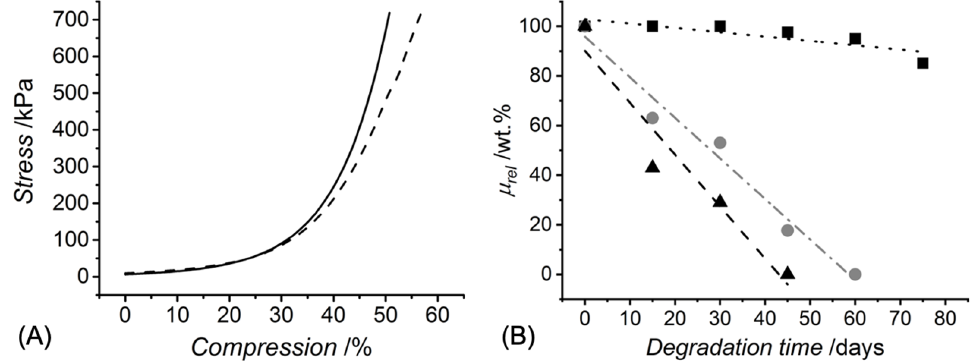
Figure 2. ( A ): stress-compression curves of hydrogels 4VBC-MA* prepared with either 0.4 ( – – ) or 0.8 wt.-% ( — ) concentration of sequentially-functionalised CRT. ( B ): relative mass profiles displayed by UV-cured hydrogels 4VBC-MA* ( ■ , ∙∙∙ : y = 102.85 − 0.18x, R 2 = 0.71), 4VBC* ( ● , ─ ∙ ─ : y = 95.8 − 1.64x, R 2 = 0.98), and GMA* ( ▲ , – – : y = 90.1 − 2.09x, R 2 = 0.93) during hydrolytic degradation in vitro (37 °C, pH 7.4).